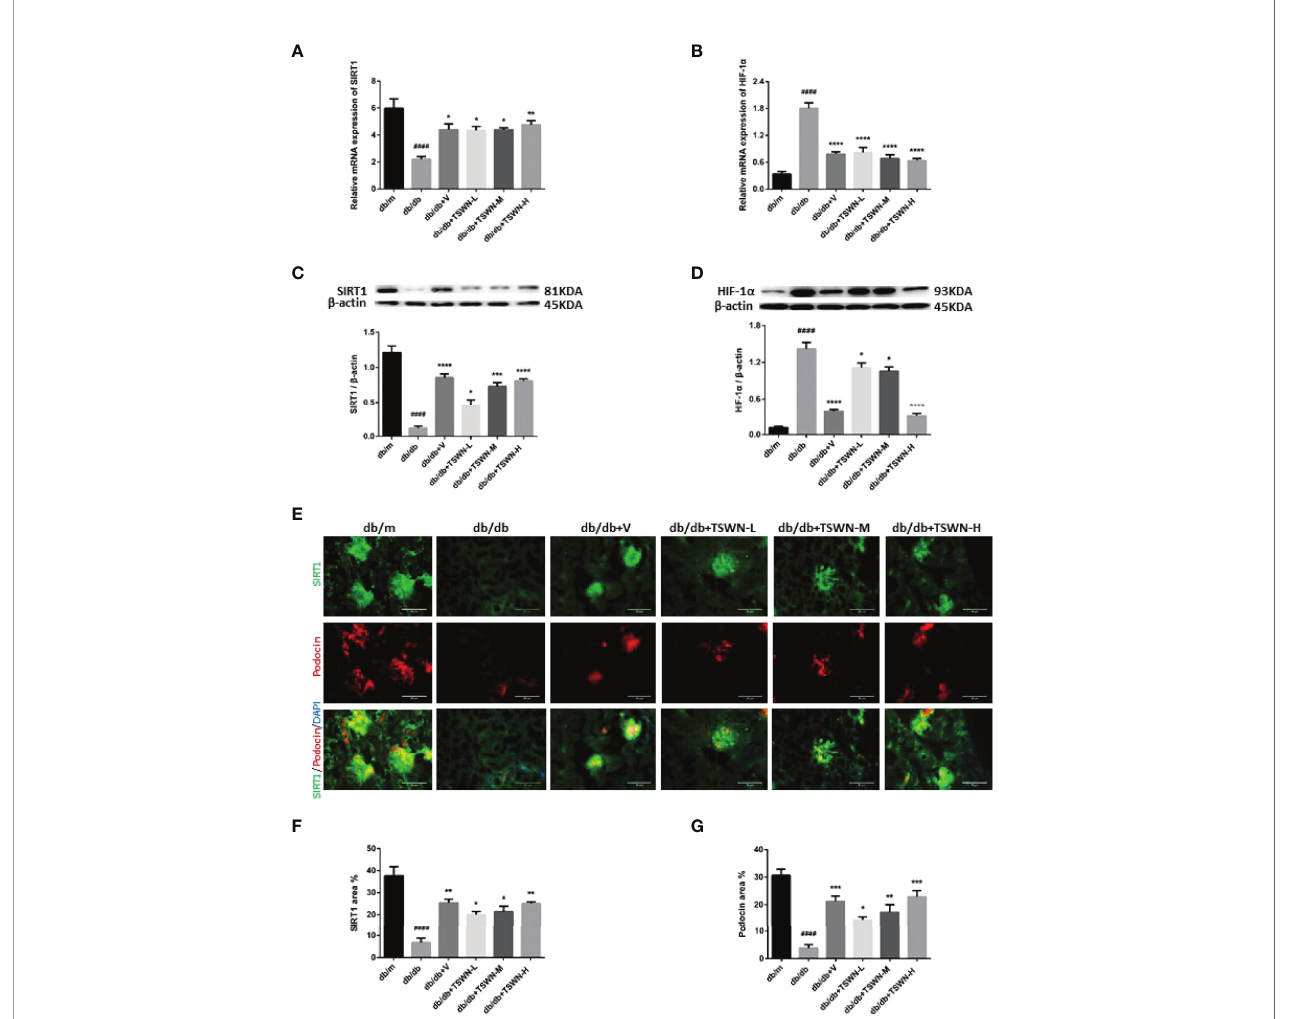
FIGURE 7 | SIRT1 and HIF-1a in mouse kidneys. (A) Messenger ribonucleic acid (mRNA) expression of SIRT1 in mouse kidneys by quantitative reverse transcriptase polymerase chain reaction (RT-PCR). (B) MRNA expression of HIF-1a in mouse kidneys by RT-PCR. (C) Representative photographs and quanti fi cation of SIRT1 in mouse kidneys measured by western blot. (D) Representative photographs and quanti fi cation of HIF-1a in mouse kidneys measured by western blot. (E – G) Representative photographs and quanti fi cation of co-staining of SIRT1 and podocin in mouse kidneys. n = 6 mice/group. #### P < 0.0001 vs db/m group; *P < 0.05, **P < 0.01, ***P < 0.001, ****P < 0.0001 vs db/db group. Db/m, db/m mice; db/db, db/db mice; db/db+V, db/db mice with valsartan treatment; db/db+TSWN-L, db/ db mice with low dose TSWN treatment; db/db+TSWN-M, db/db mice with middle dose TSWN treatment; db/db+TSWN-H, db/db mice with high dose TSWN treatment. Data are means ±